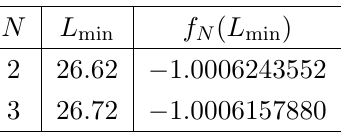
Table 9 . Local minimum values of f N ( L ) for N = 2 ; 3 in Siegel